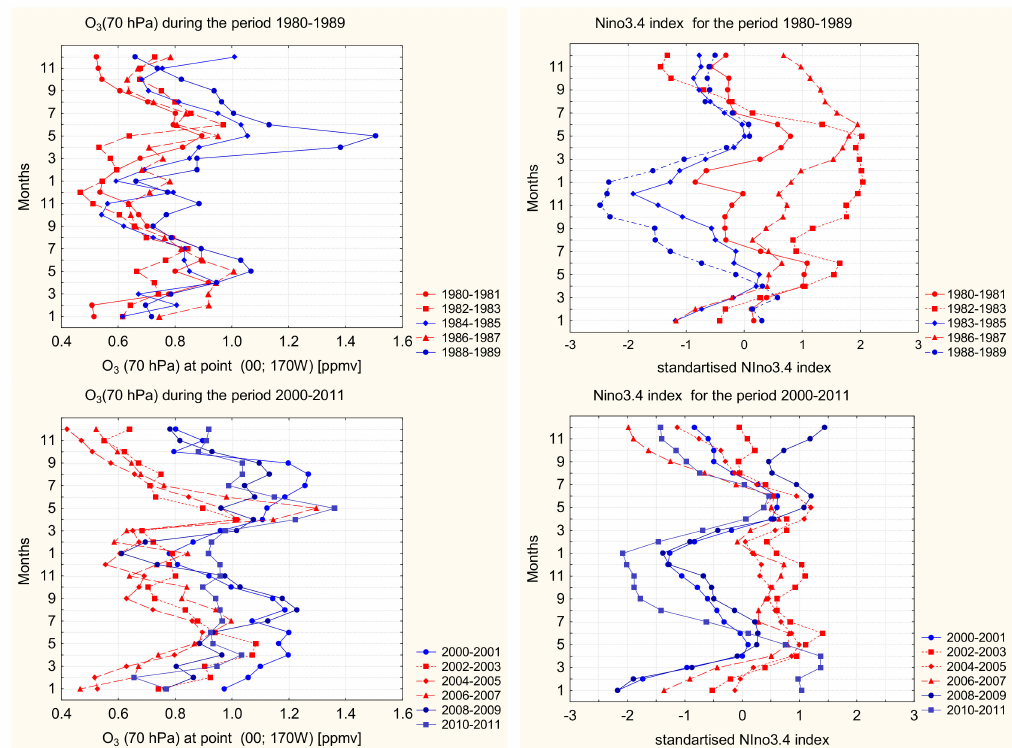
Figure 6. Two year time series of ozone at 70 hPa (left column) and Nino3.4 index (right column) corresponding to La Niña (blue curves) and El Niño (red curves), for two decades: 1980–1989 (top panels) and 2000–2011 (bottom ones).